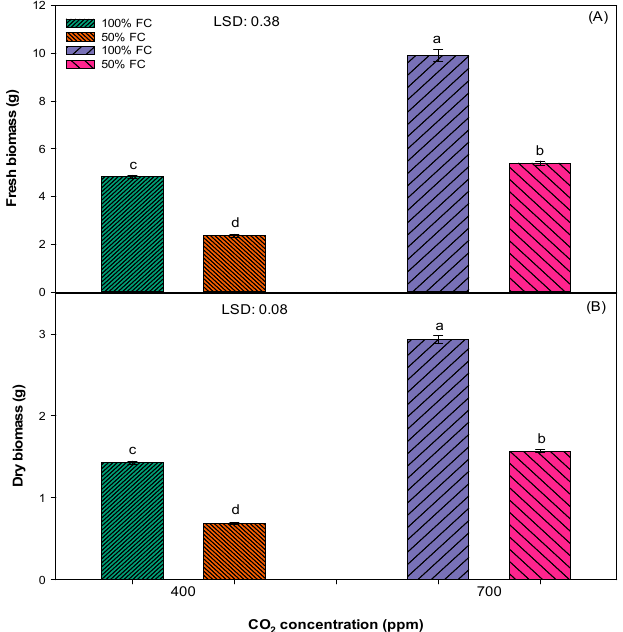
Figure 3. Effect of different [CO 2 ] and soil moisture levels on ( A ) fresh biomass and ( B ) dry biomass of S. cannabina . The experiment was repeated, and the pooled data from the two studies are presented here. The vertical bars represent error bars ( n = 12). LSD represents the least significance difference ( p ≤ 0.05; n = 12). Different letters (a, b, c, d) on the error bars indicate significant differences, as determined by Fisher’s protected LSD test at p < 0.05. The abbreviation FC in the figure represents the field capacity.